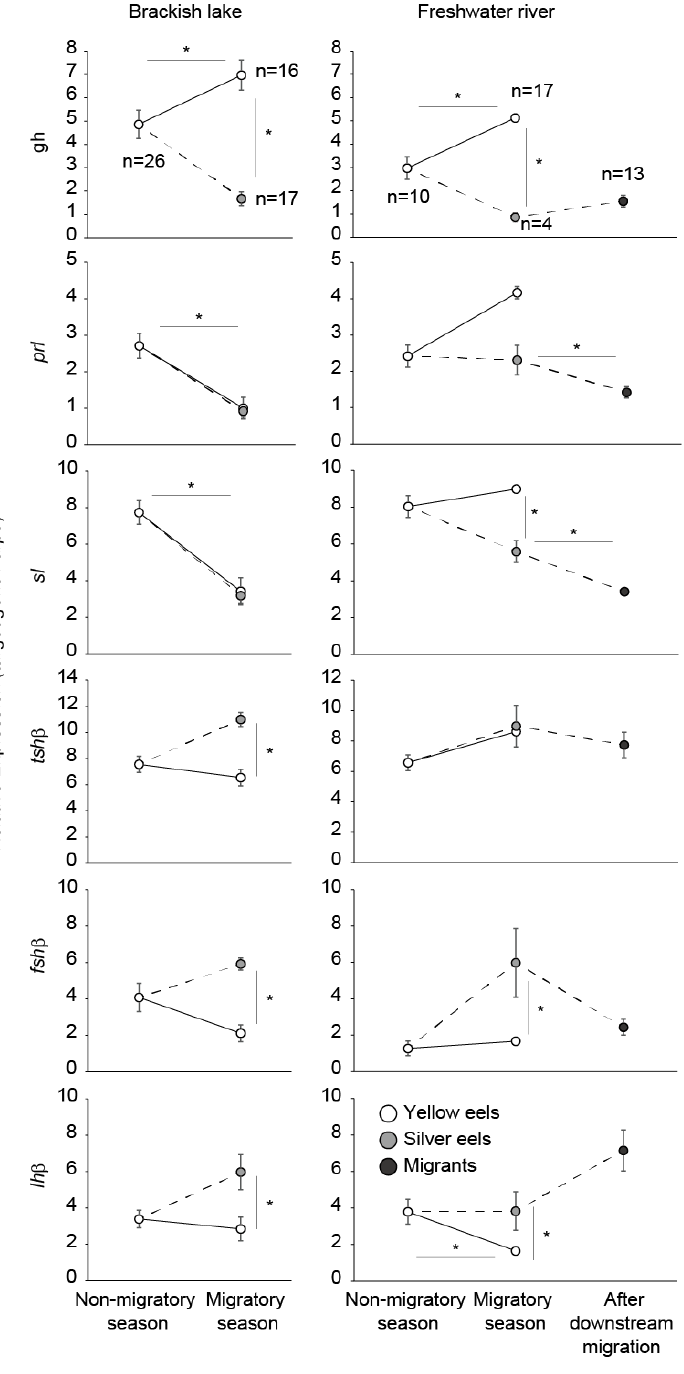
Figure 3. Seasonal differences of mRNA-expression of pituitary hormones for female yellow eels and silver eels ( A. japonica ) from a brackish lake and its freshwater inlet rivers. White circles indicate yellow eels, gray circles show silver eels, and black circles show migrants, which are the silver eels after downstream migration. Data are means ± standard error. Asterisks show significant differences between each group ( p < 0.05; Steel-Dwass). This figure is based on data from Sudo et al. 2011 [42] and Sudo et al. 2013